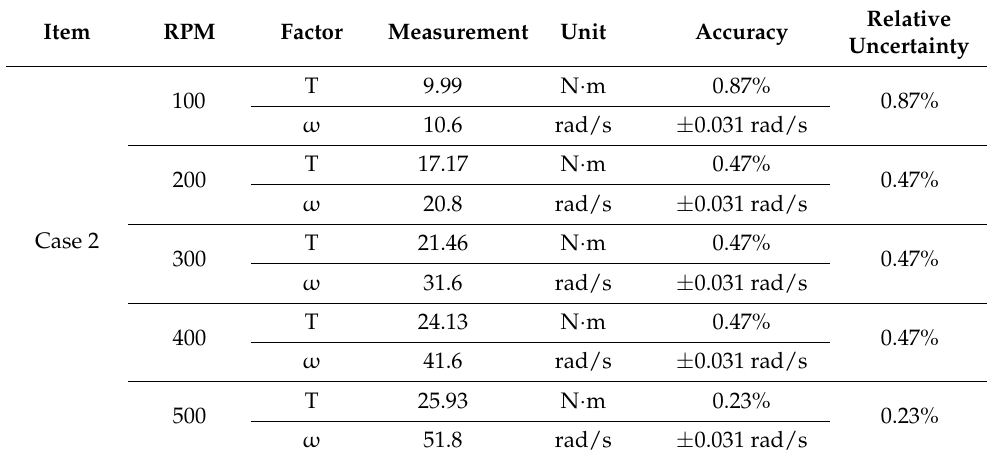
Table 5. Relative uncertainty of case 2 in terms of output energy.